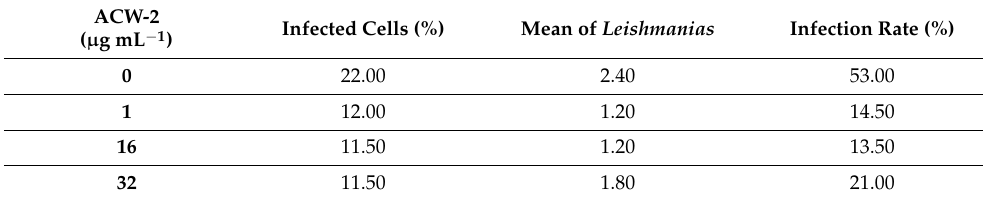
Table 2. Data on ACW-02 microbicidal effect assay.